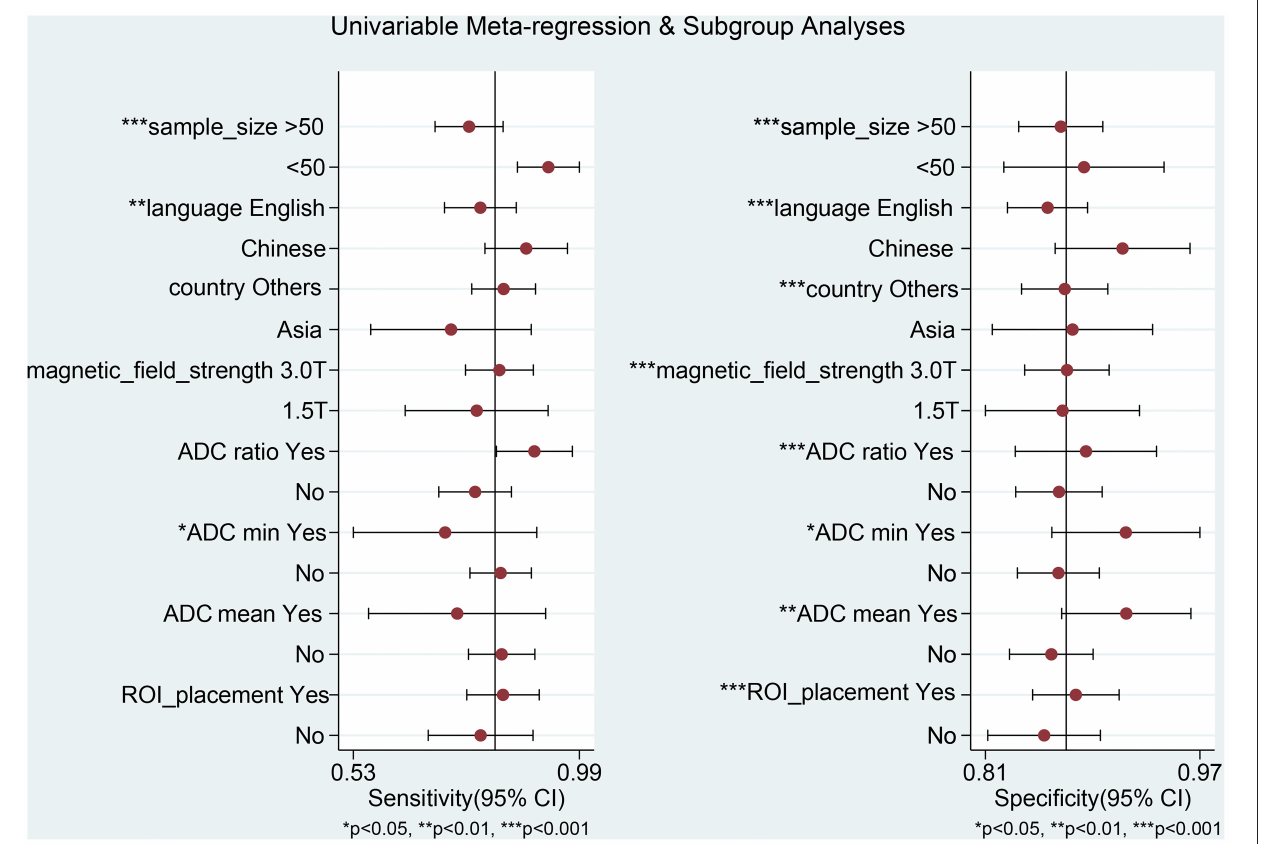
FIGURE 5 | Univariable meta-regression analysis for the sensitivity and specificity of DWI for differentiating between primary central nervous system lymphoma (PCNSL) and high-grade glioma (HGG).